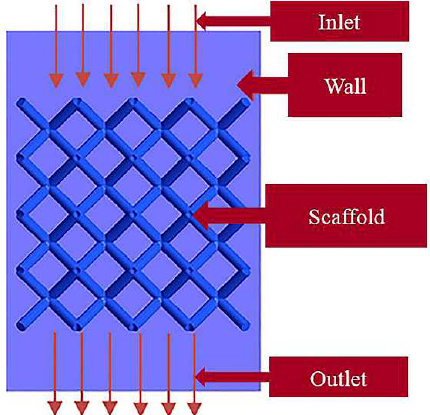
Figure 2. Schematic diagram of simulation boundary conditions.